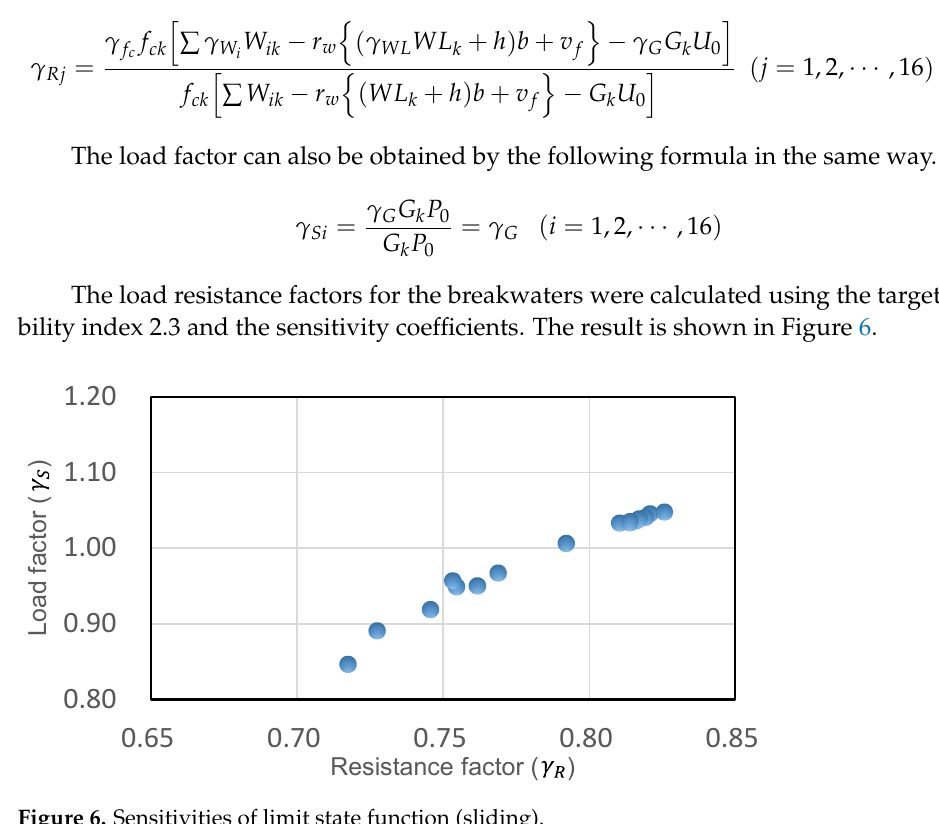
Figure 5. Sensitivities of limit state function (sliding).